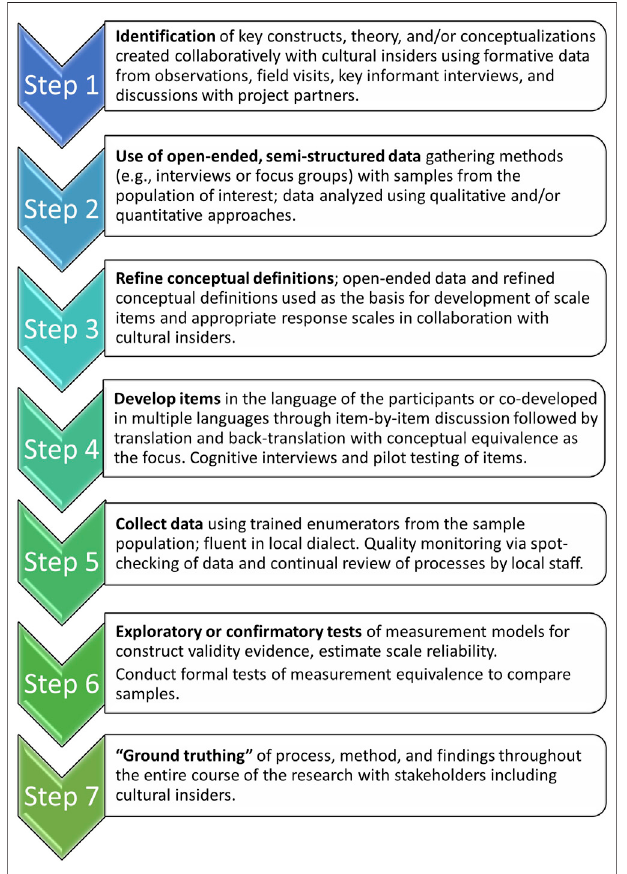
FIGURE 1 | Proposed model for communication measurement development in cultural context: model for culturally contextualized communication measurement (MC 3